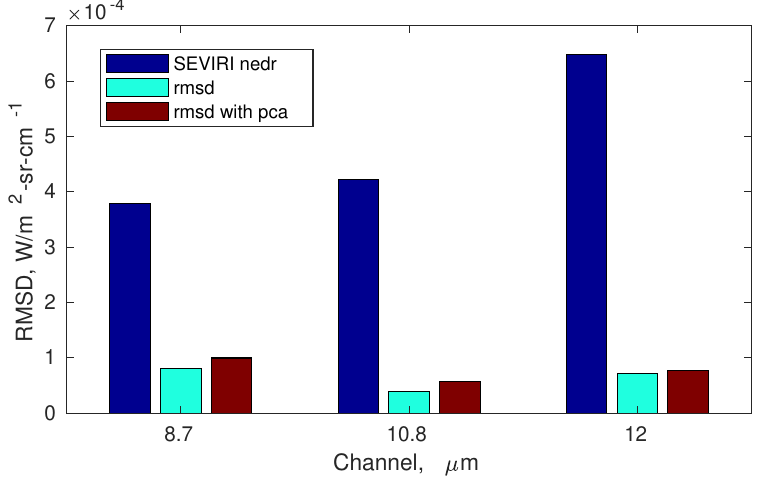
Figure 3. Radiance root means square difference or rmsd (reconstructed-true) for the three SEVIRI channels and comparison with the corresponding radiometric noise. The rmsd is shown for the old ( σ -SEVIRI) and new version ( σ pc -SEVIRI) of the forward model described in this